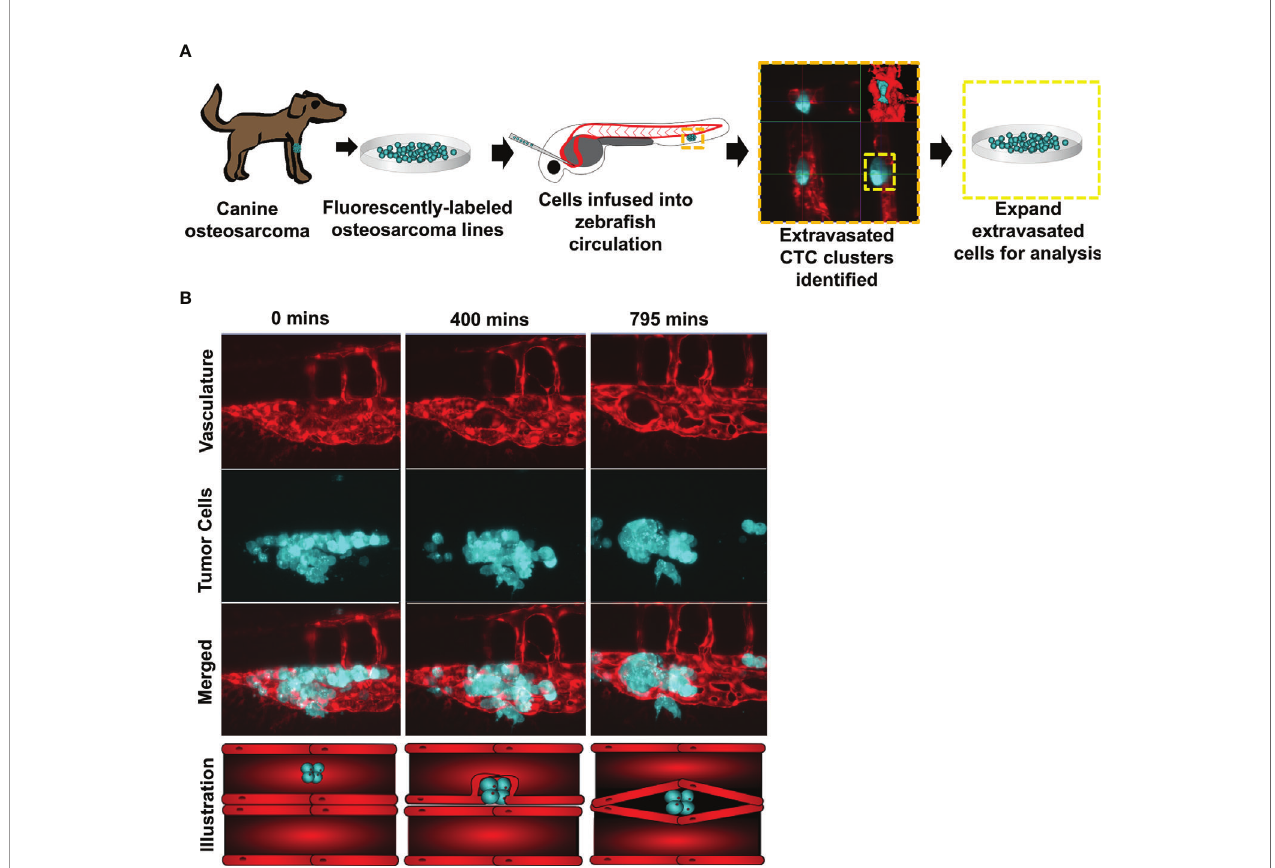
FIGURE 1 | Circulating canine osteosarcoma clusters extravasate by angiopellosis. (A) Illustration of the project work fl ow. Canine osteosarcoma cell lines were fl uorescently labeled and infused into the circulation of Tg( fl i1a:egpf ) with fl uorescent blood vessels. Tumor cells which extravasated as clusters were isolated and expanded, and these sub-lines were then molecularly pro fi led. (B) Representative image of infused D17 tumor cells aggregating as clusters in zebra fi sh circulation. Tumor cell clusters begin to extravasate through the endothelial cells of the blood vessels during metastasis. The tumor cluster is eventually completely removed from the inside of the vessels and is lodged in an extravascular cavity while maintaining multicellularity and not disassociating into single cells. SB =